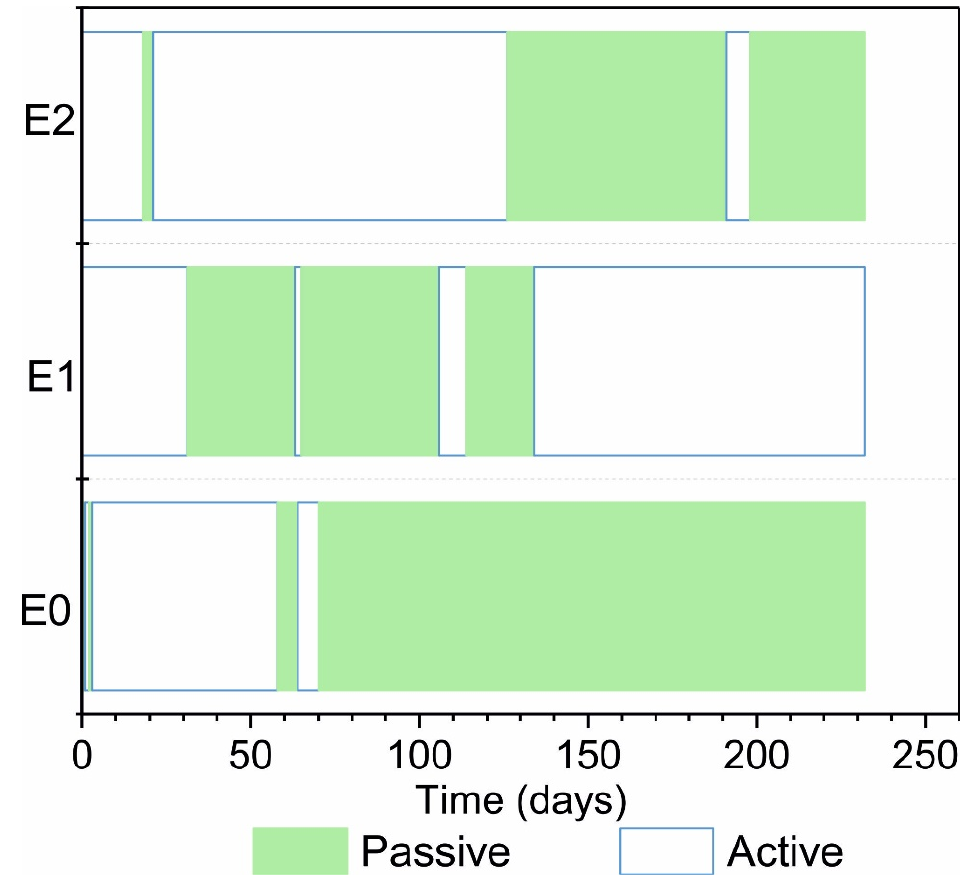
Figure 9. Activation and passivation timing, assuming a threshold value of 0.2 µA/cm 2